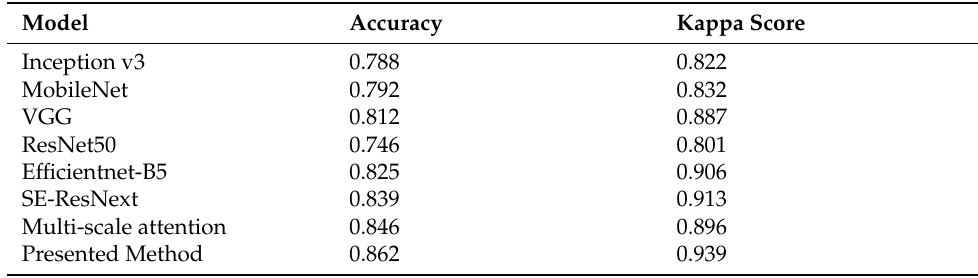
Table 6. Quantitative